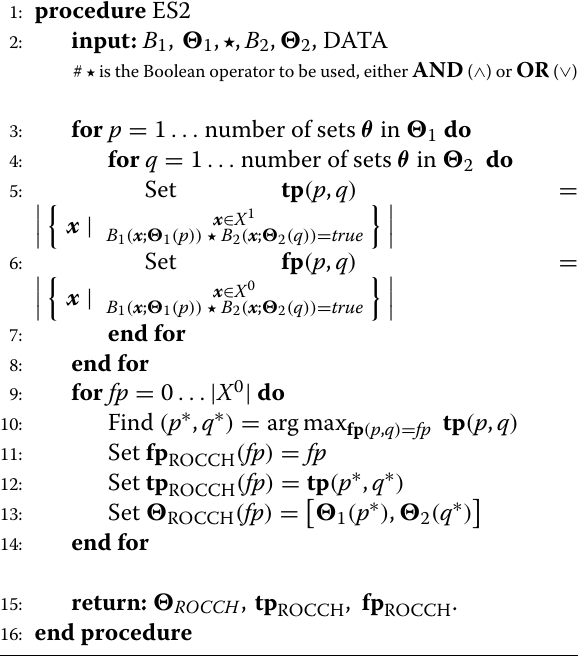
Algorithm 3 Exhaustive search of ROCCH operating points for a Boolean combination of two